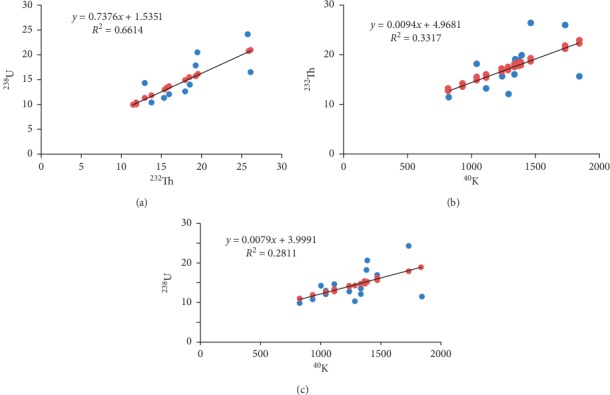
Regression plots showing the correlation between (a) 238U and 232Th, (b) 232Th and 40K, and (c) 238U versus 40K in sand samples analysed.